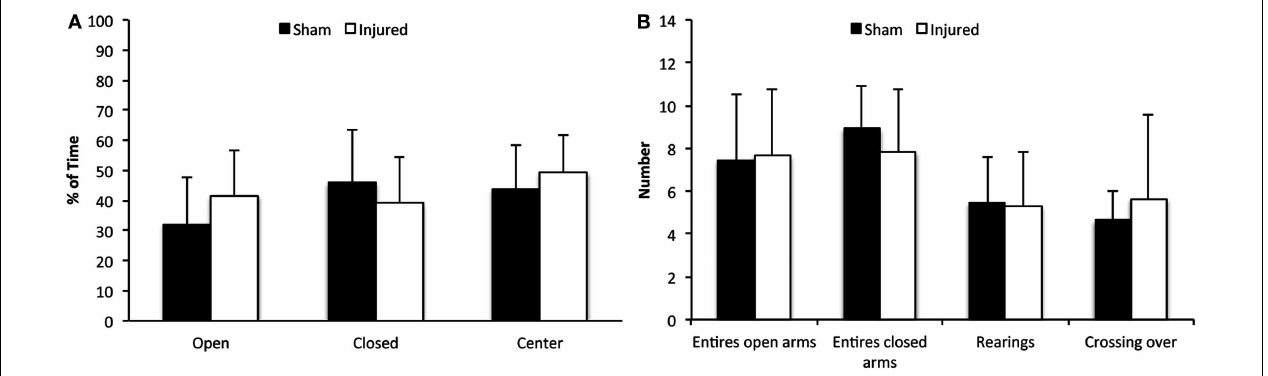
the EPM, compared to control animals (A) , this difference was not